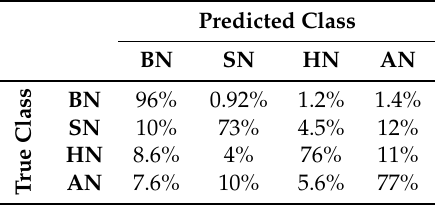
Table 7. Results achieved by the 2D CNN and Mel spectrogram as input.